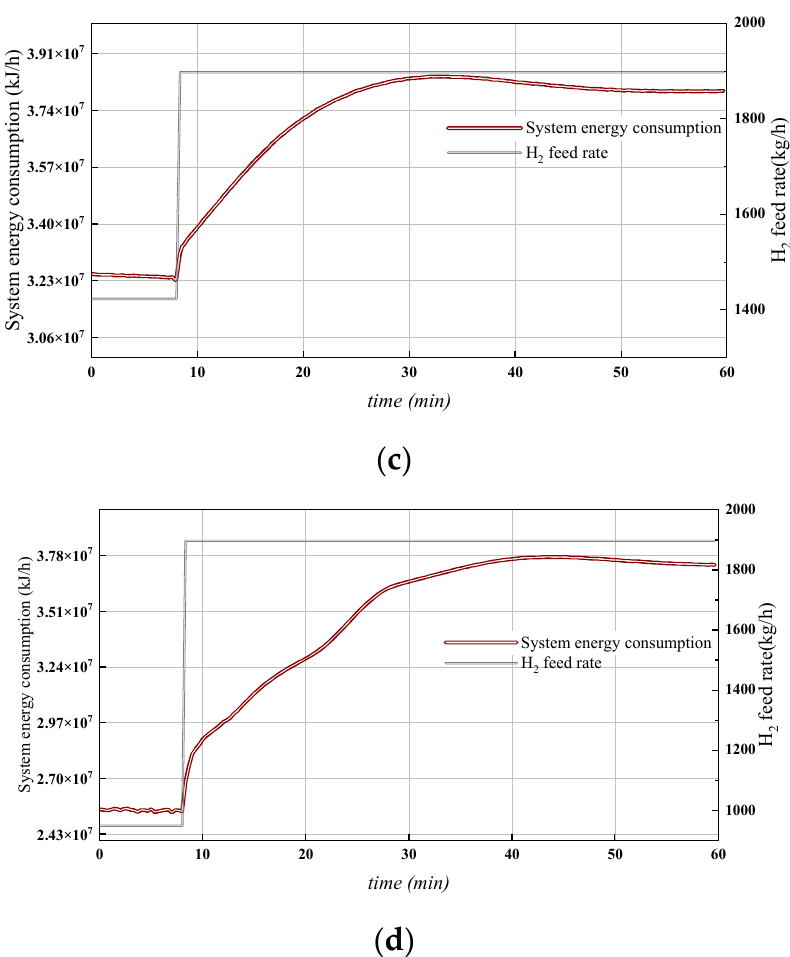
Figure 6. Energy consumption fluctuation curves caused by flow change in the transition state process: ( a ) process ① energy consumption curve; ( b ) process ② energy consumption curve; ( c ) pro- cess ③ energy consumption curve; and ( d ) process ④ energy consumption curve.